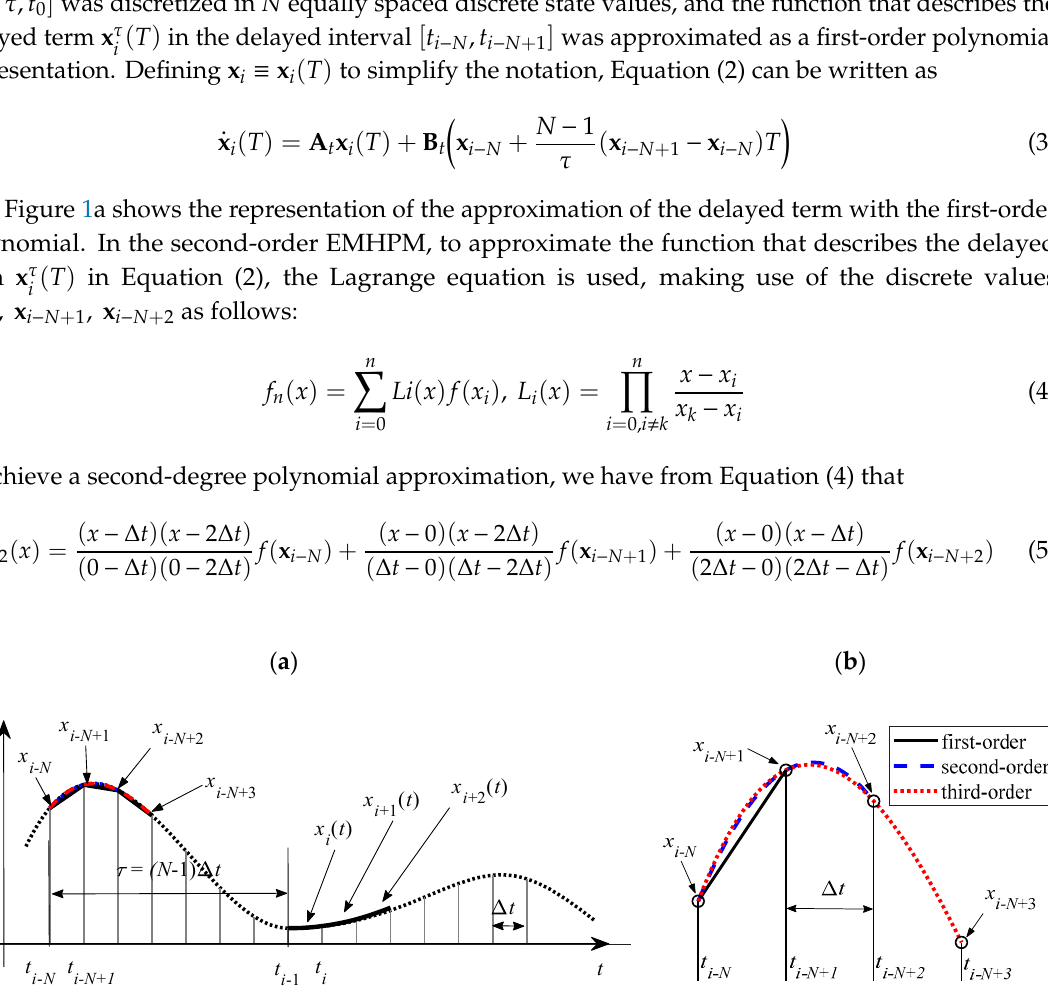
Figure 1. ( a ) Scheme for the approximation of the delayed term by a first-order (solid black line), second-order (dashed blue line) and third-order (dotted red line) polynomial: ( b ) zoom in the time interval [ t i − N + 1 , t i − N + 3 ].